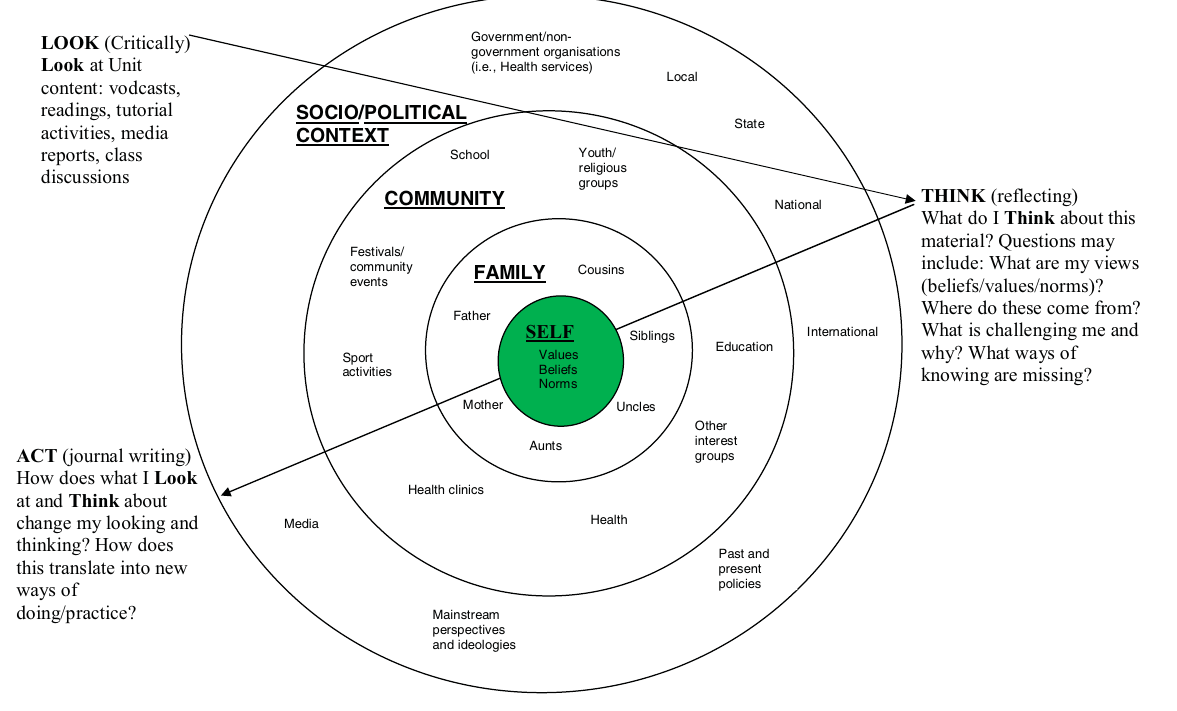
(Colour online) Critical